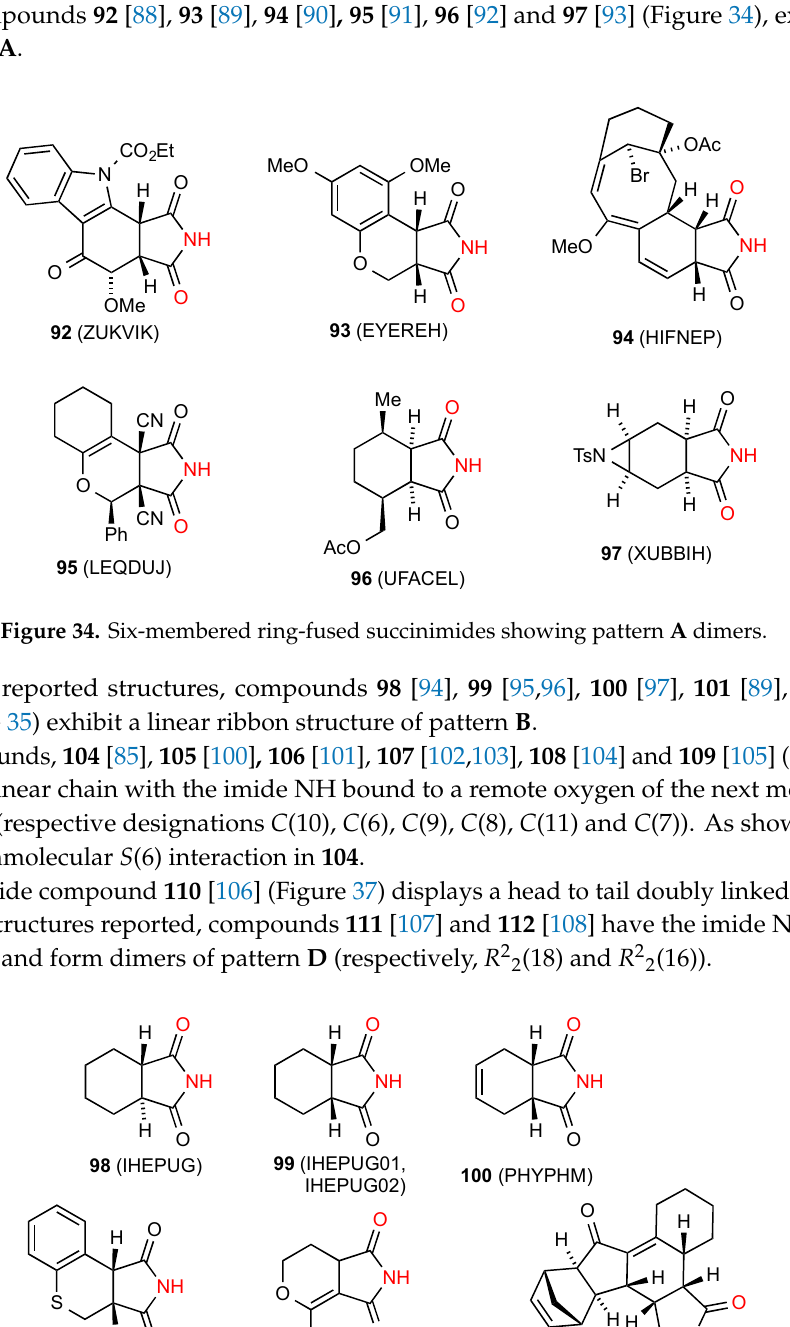
Figure 35. Six-membered ring-fused succinimides showing pattern B ribbons.